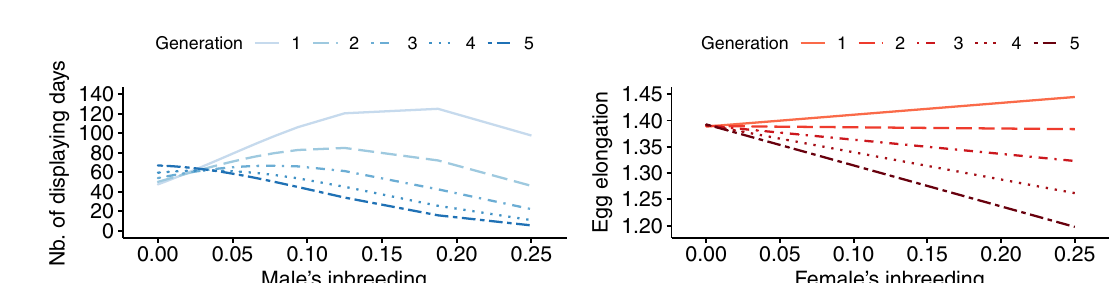
Figure 5. Predicted values of the reproductive parameters according to the interaction between age and number of generations in captivity.